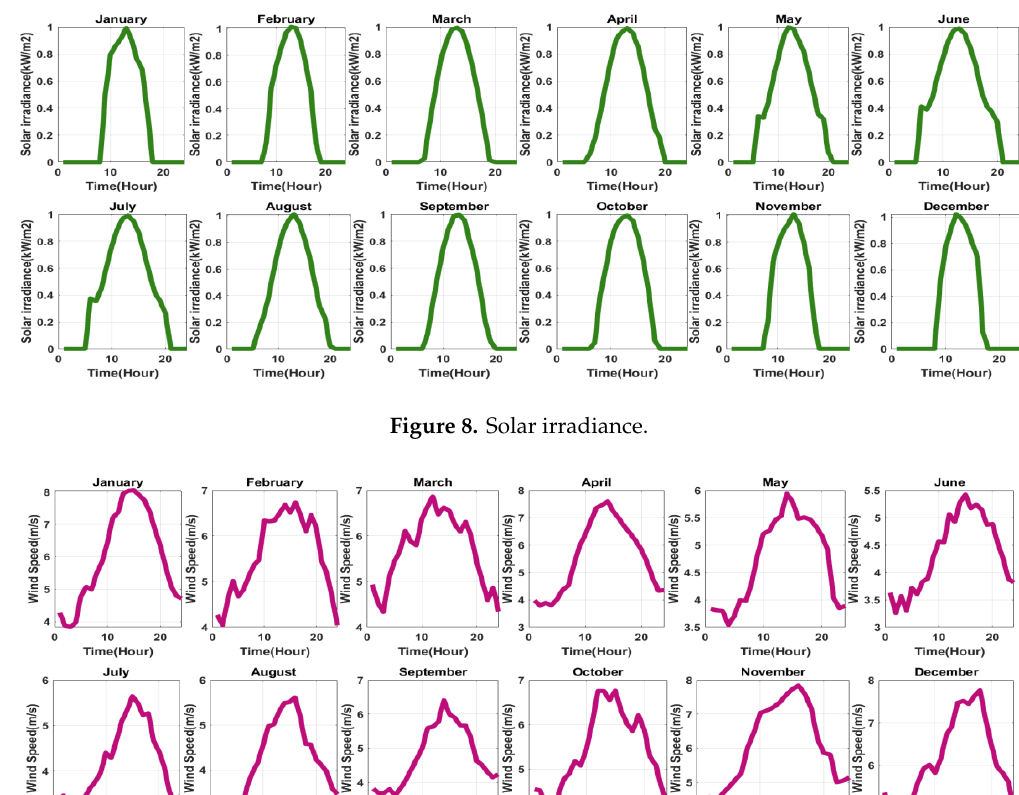
Figure 7. Temperature.